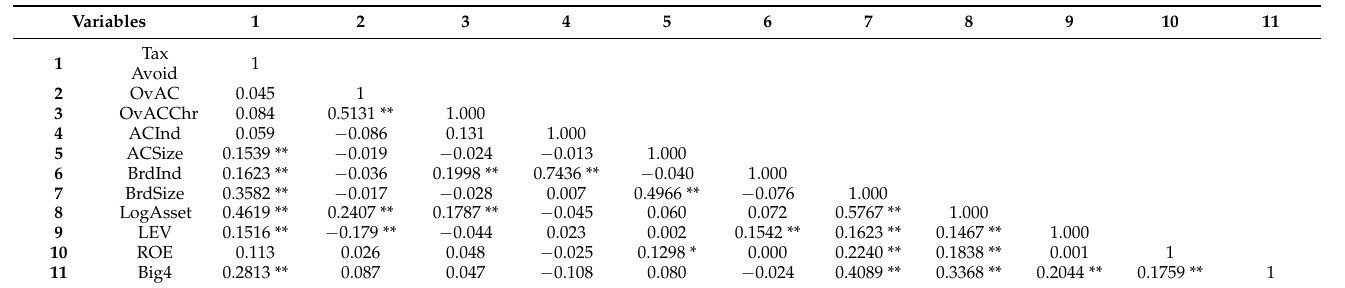
Table 3. Pearson correlation analysis.